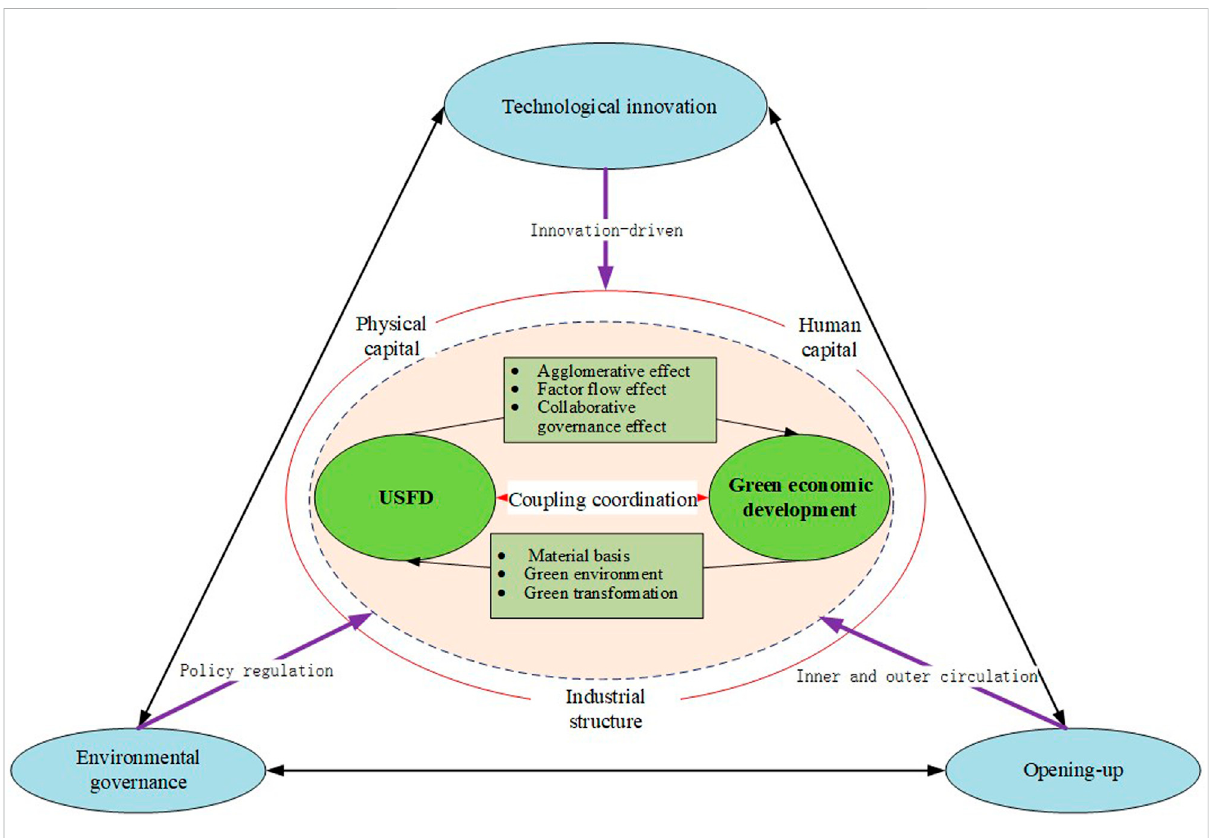
FIGURE 1 Coupling coordination relationship and driving mechanism between USFD and green economic